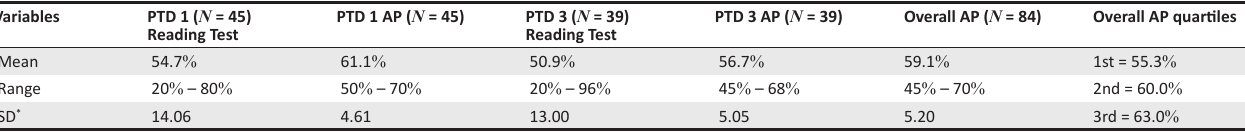
Source : Data compiled by author for article Values are given as means. PTD, Primary Teacher’s Diploma; AP, Academic Performance; SD, Standard